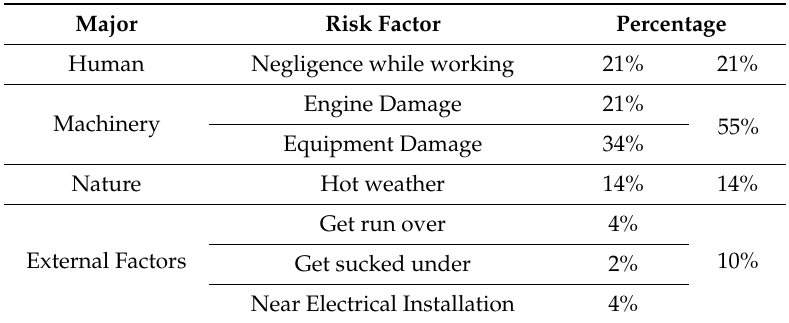
Table 6. Percentage of common causes of